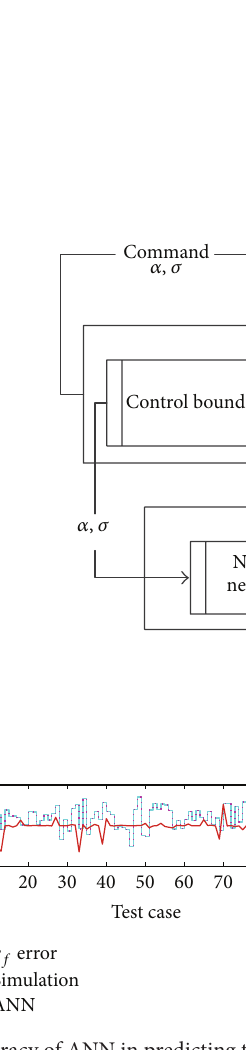
Figure 9: Accuracy of ANN in predicting terminal velocity.